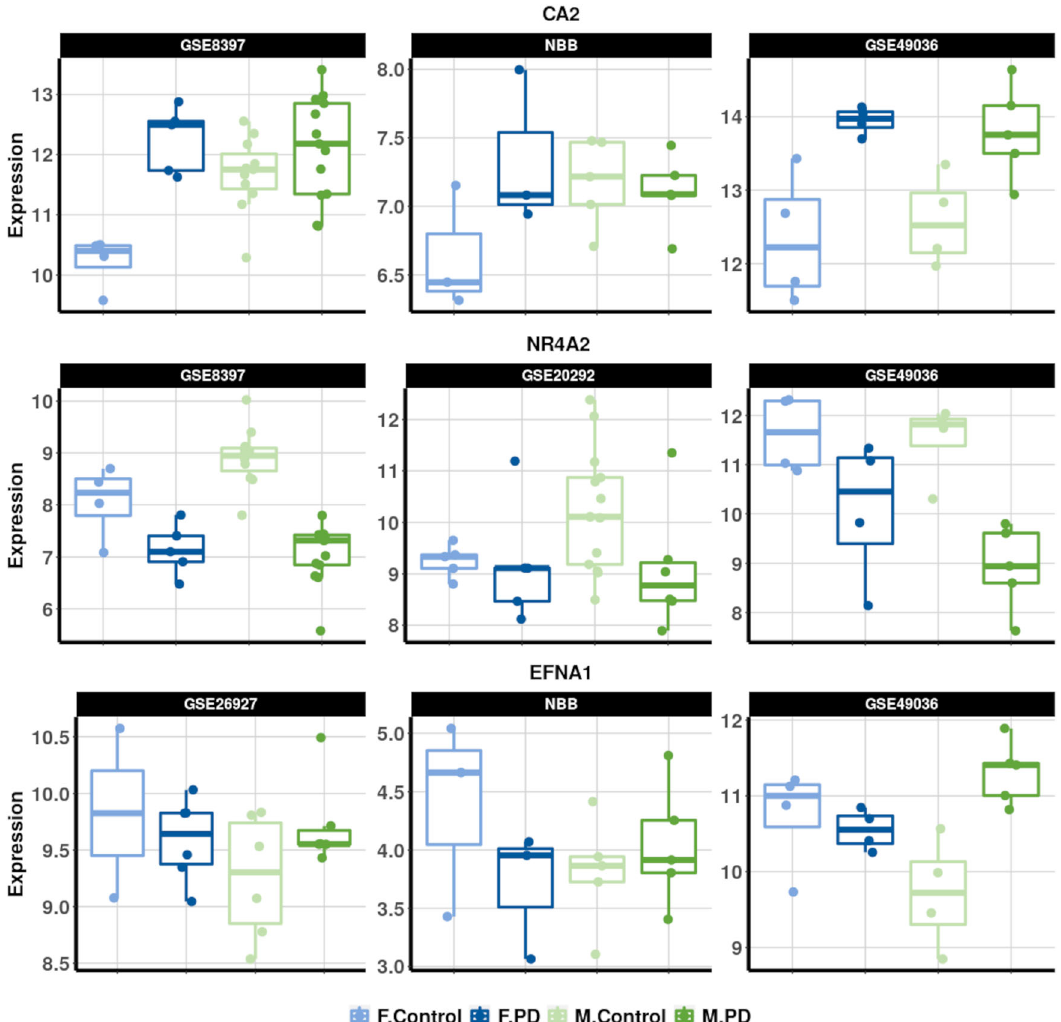
Fig. 1 Expression levels of selected differentially expressed genes in representative datasets. The selected genes are CA2 (top, female- speci fi c), NR4A2 (middle, male-speci fi c), and EFNA1 (bottom, candidate sex-dimorphic). Each subplot contains four boxplots corresponding to the four categories of interest: female controls (light blue), female PD patients (dark blue), male controls (light green) and male PD patients (dark green). The data used to produce the boxplots is the pre-processed transcriptomics data. Each boxplot is represented by the median, two hinges (representing the fi rst and third quartiles) and two whiskers (extending up to 1.5 × inter-quartile range from the